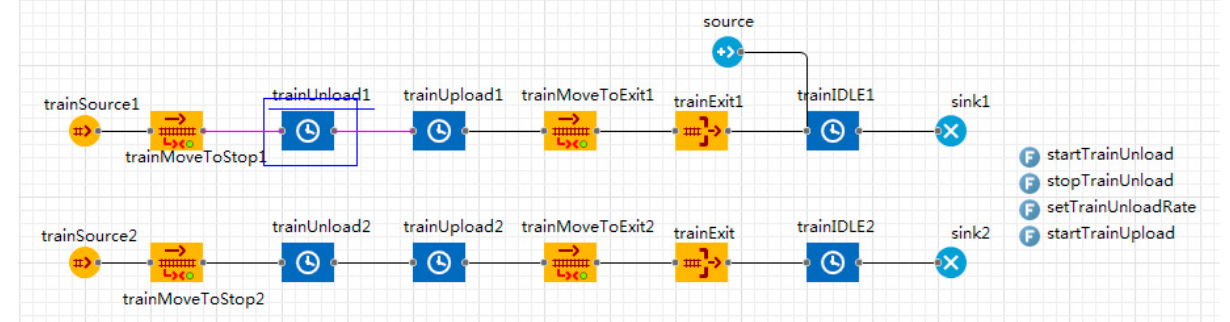
Figure 7. Train operation simulation modeling.